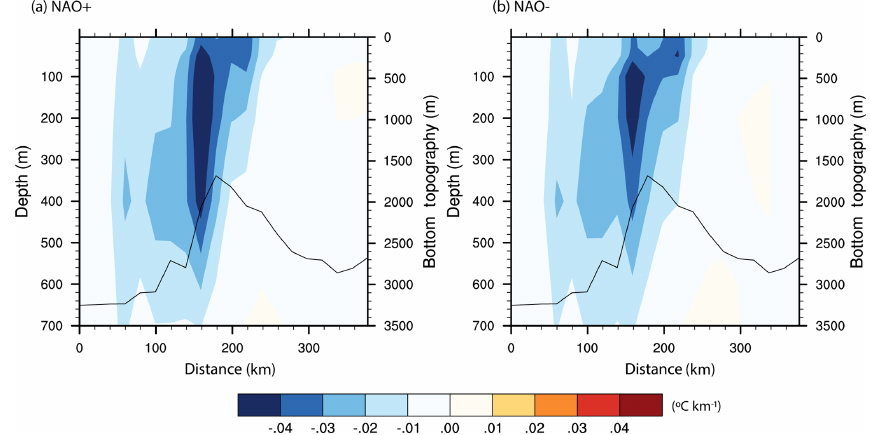
Figure 8. Gradient in the mean potential temperature ( ◦ Ckm − 1 ) along the hydrographic section across the Mohn Ridge during (a) NAO + and (b) NAO − . The bottom topography along the section is indicated by the black